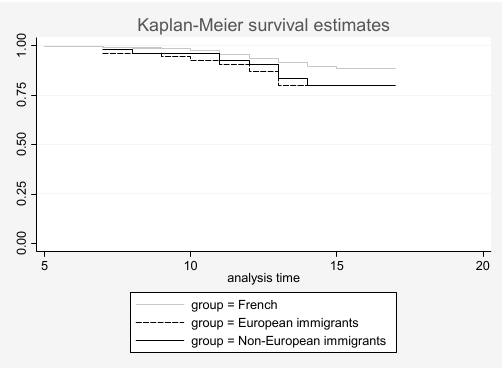
Figure 1. Frequency of French, European-immigrant, and non-European-immigrant adolescents with no suicide attempt according to age (year). The log-rank test for equality of the “survivor functions” (for suicide attempt) was significant with p = 0.016 (and with p = 0.005 when European and non-Europeans were grouped).